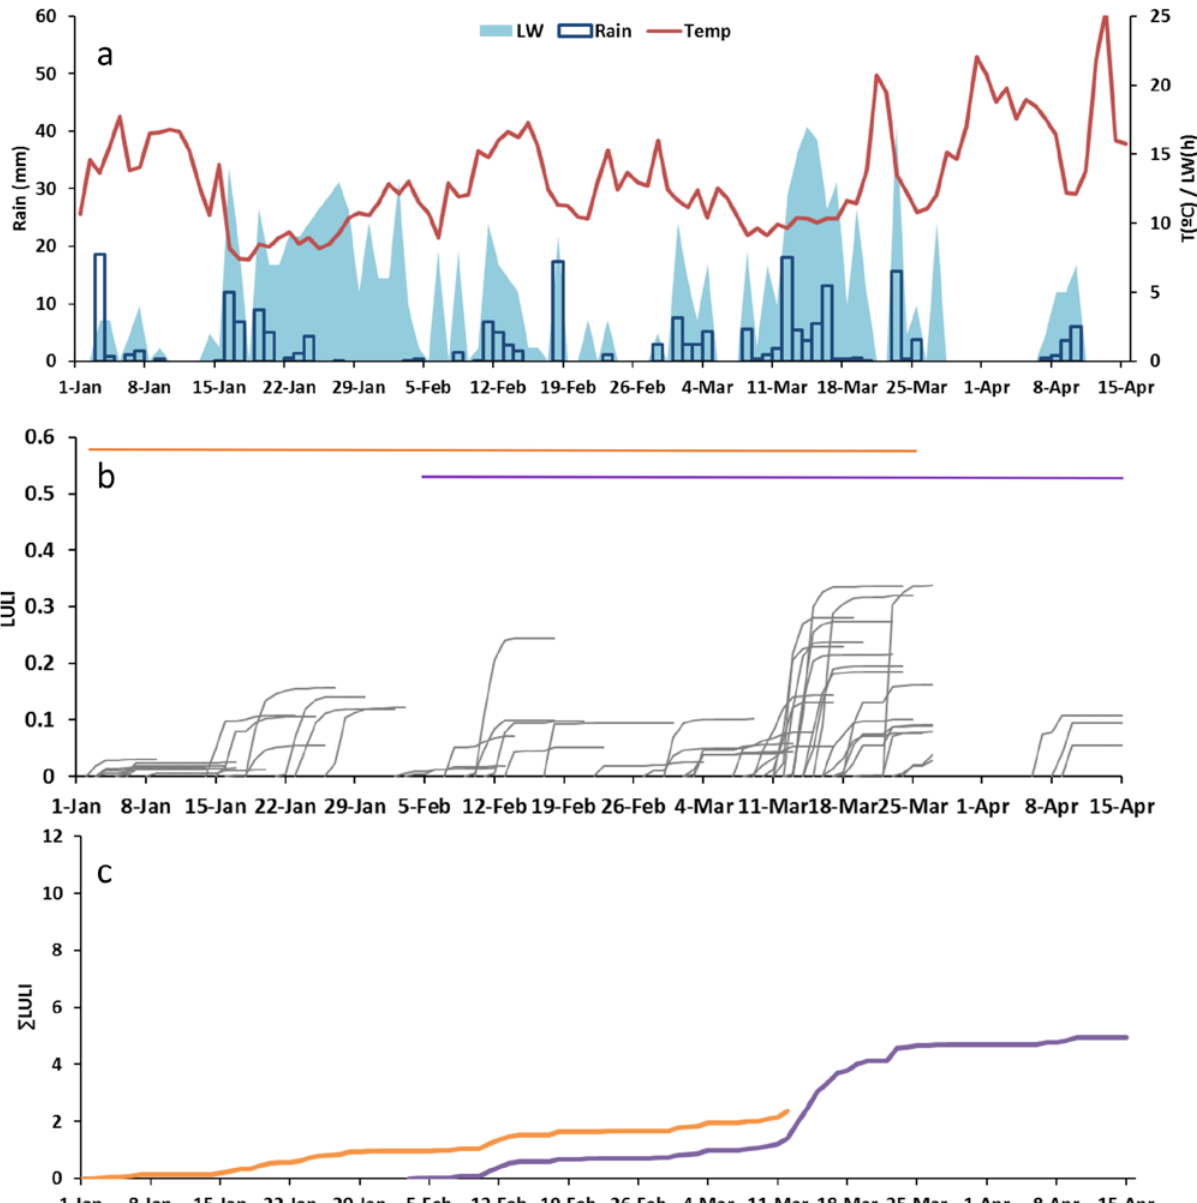
Figure 5. Weather data and model output for 2016. a: daily weather data; b: predicted increase of latent infections (LULI) for each infection period; c: predicted seasonal dynamics of the cumulative values of LULI (∑LULI) for cv. Peluche and Algerie (orange line) and for cv. San Filipparo (purple line). Coloured lines at the top in b represent the periods in which the model was operated for cv. Peluche and Algerie (orange line) and for cv. San Filipparo (purple